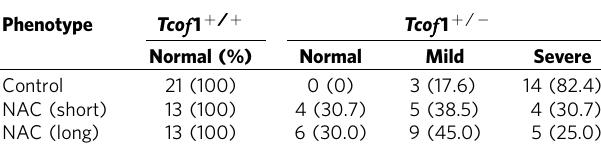
Table 1 | Craniofacial phenotype with or without NAC treatment.